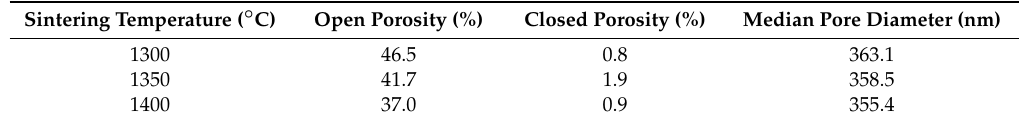
Table 2. Porosities and median pore diameters of porous Al 2 O 3 ceramics (40 vol.% Al 2 O 3 in the slurries).